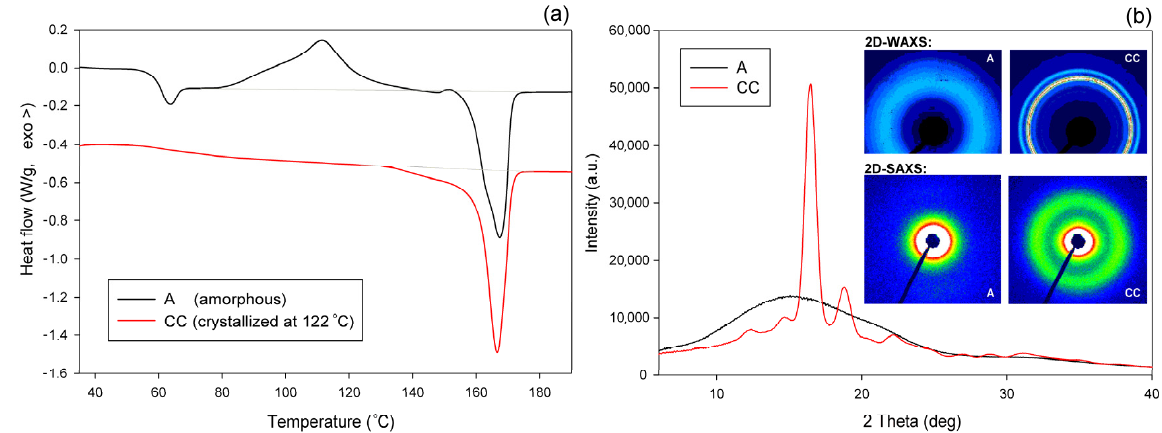
Figure 3. DSC thermograms ( a ) and X-ray diffractograms ( b ) of initial amorphous sample A and semicrystalline sample CC, cold crystallized at 122 °C. Insets show the respective 2D-WAXS and 2D-SAXS patterns. Table 1. The characteristics of initial amorphous (A) and cold crystallized (CC) samples. Sample